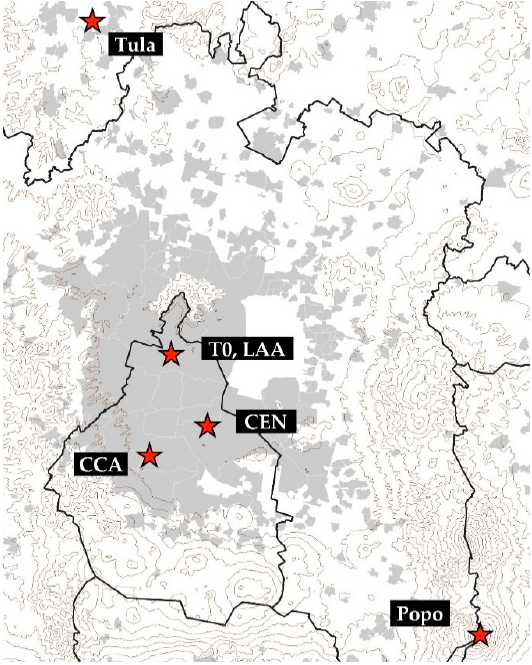
Figure 1. Map of the Mexico City Metropolitan Area, showing the sites mentioned in the text (red stars). Thick black lines represent state boundaries, and thin grey contour lines represent topographical features. Urban areas are colored in grey. LAA: Laboratorio de Análisis Ambiental; CCA: Centro de Ciencias de la Atmósfera.